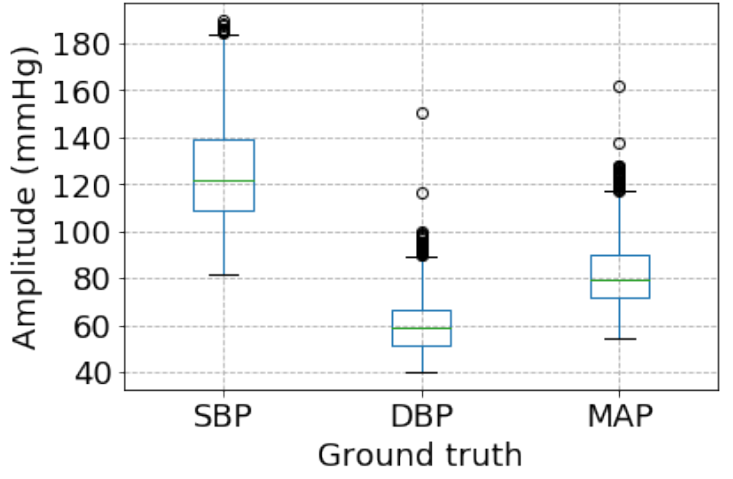
Figure 6. The boxplot of ground truth BP